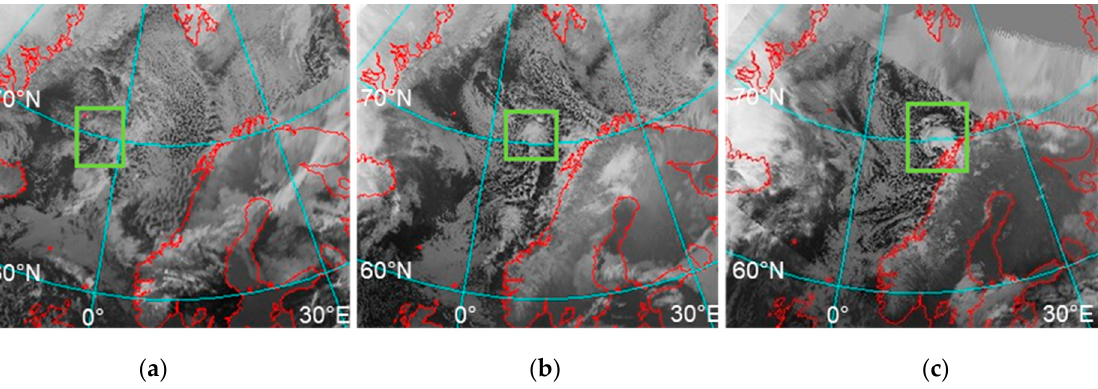
Figure 5. Satellite images of the polar low originating on March 19 east of Greenland: ( a ) 13:00 UTC 19.03; ( b ) 03:00 UTC 20.03; ( c ) 10:00 UTC 20.03. Images available from the Antarctic Meteorological Research Center (AMRC).